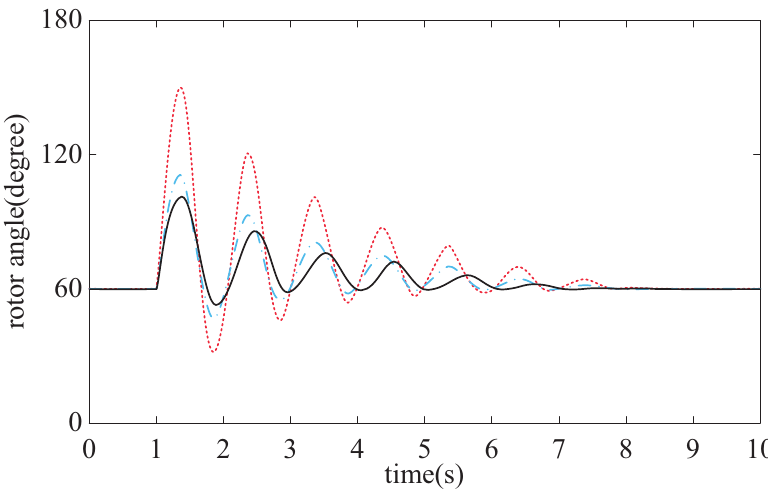
Figure 2. Response of the rotor angle under a circuit